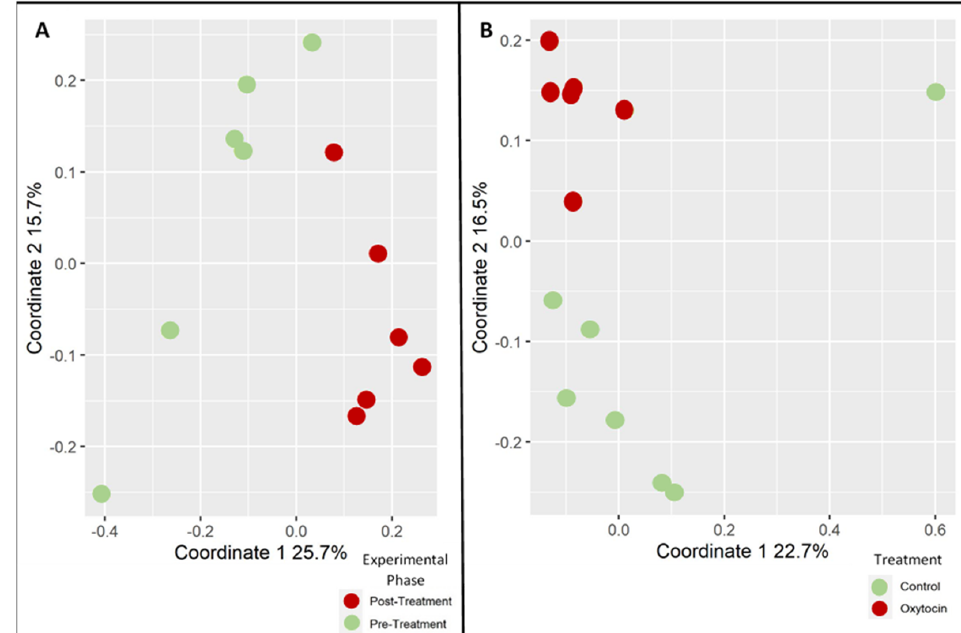
Figure 3. Oxytocin effect in a single-treatment validation experiment. Each point represents the microbiota composition of a single rat: ( A ) samples from the oxytocin-treated group only; pre-treatment (green) vs. post-treatment (red) ANOSIM, p = 0.002, R = 0.63; ( B ) all post-treatment samples, oxytocin-treated (red) or saline-treated (green) ANOSIM, p = 0.003, R = 0.44.